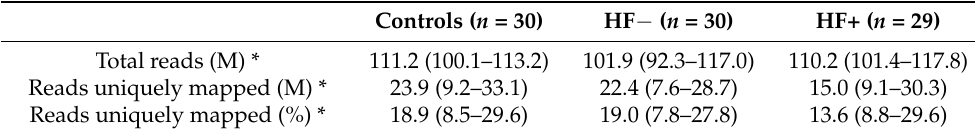
Table 1. RNA-Seq Mapping Statistics in Patients and Controls.